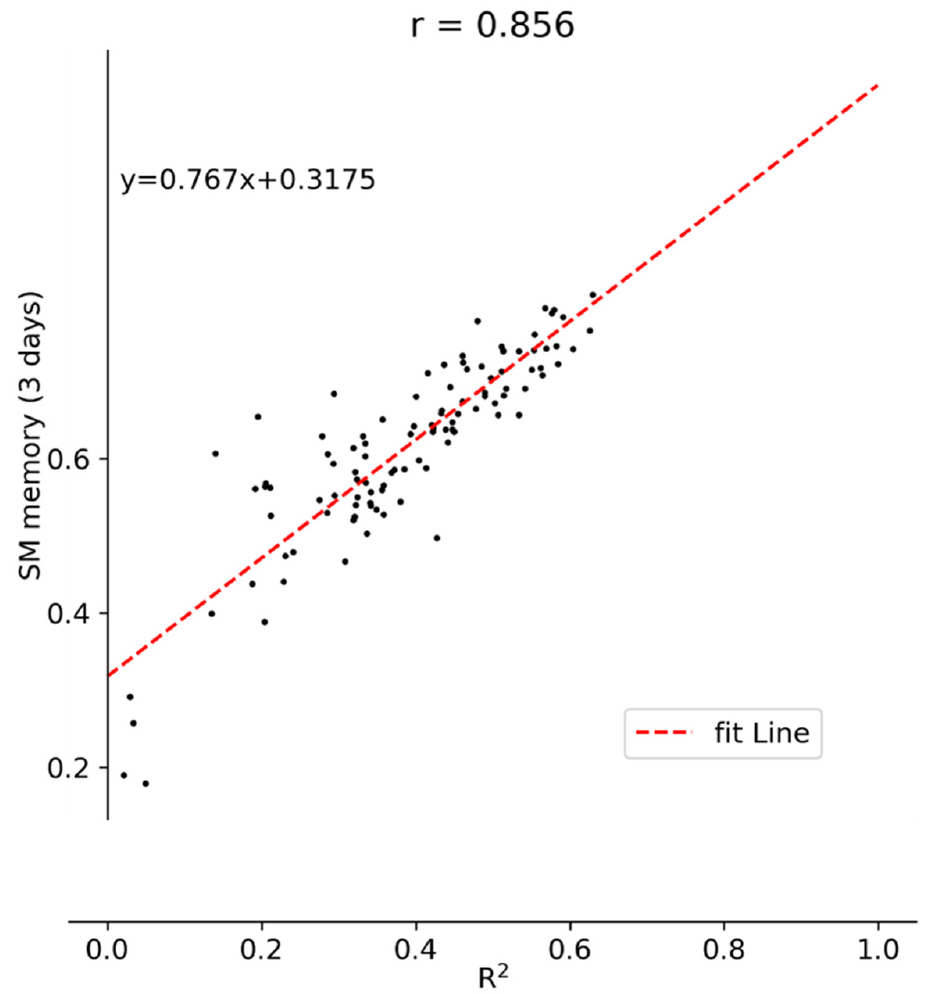
Figure 12. Time series of the original SMAP SM, the downscaled SM and the in situ SM at four stations.